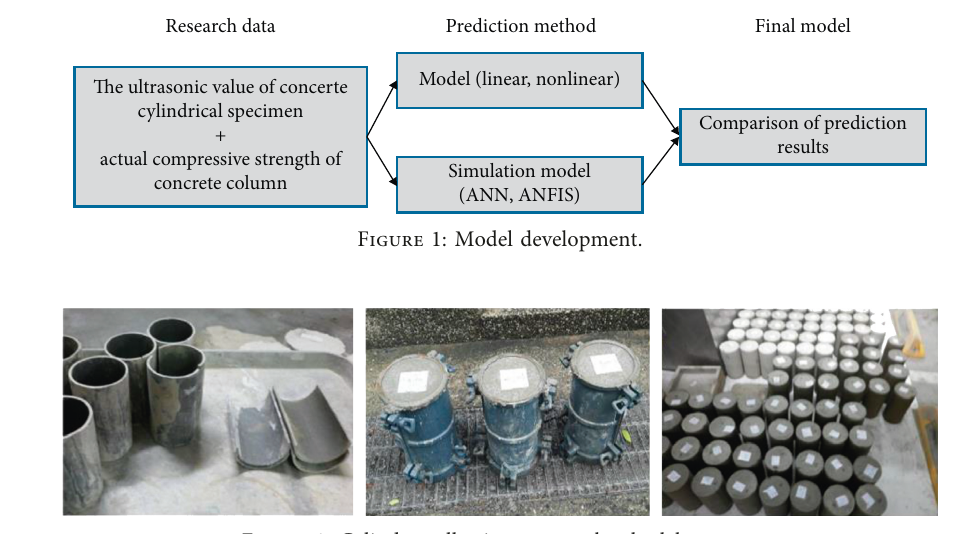
Figure 2: Cylinder collection process by the laboratory.